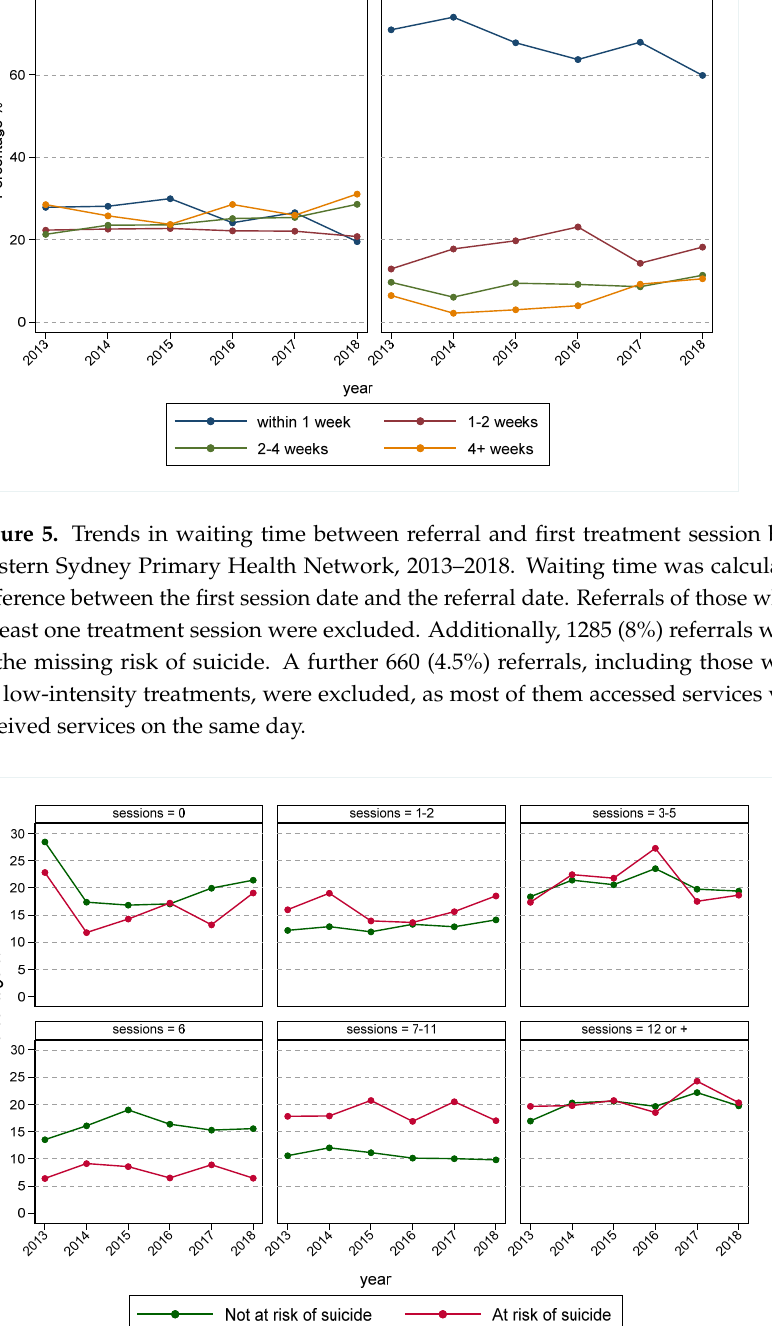
Figure 6. Trends in treatment non-attendance and sessions per referral by risk of suicide, Western Sydney Primary Health Network, 2013–2018. We excluded 2113 (10.9%) referrals. Of these